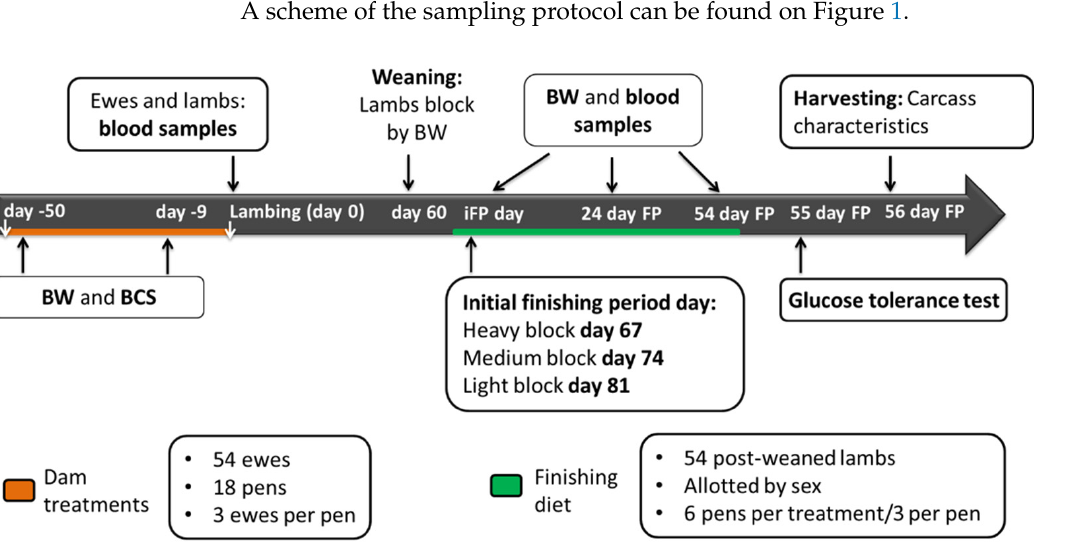
Figure 1. Timeline scheme of the feeding and sampling conducted to the dams (ewes) and the